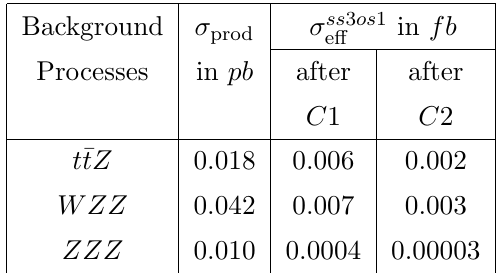
Table 14 . The production and e(cid:11)ective cross-sections ( (cid:27) ss 3 os 1